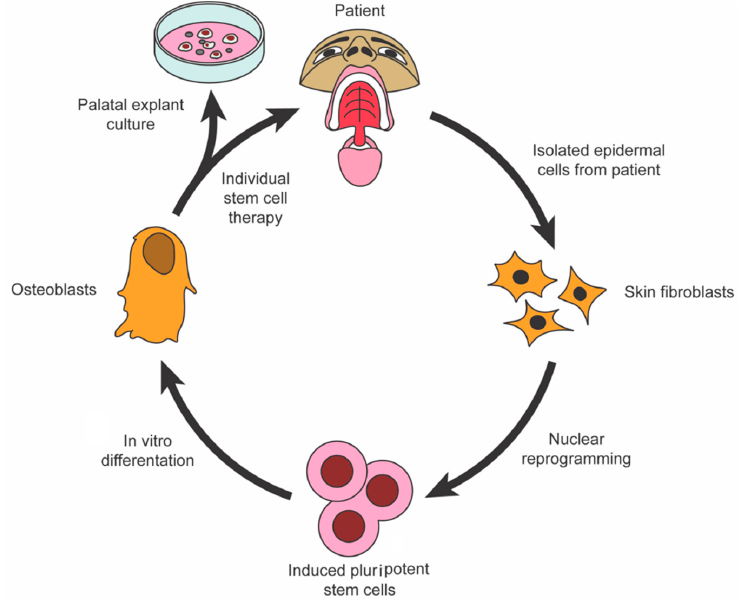
Figure 1. Isolation and programming of induced pluripotent stem cells for use in palatal bone regeneration.